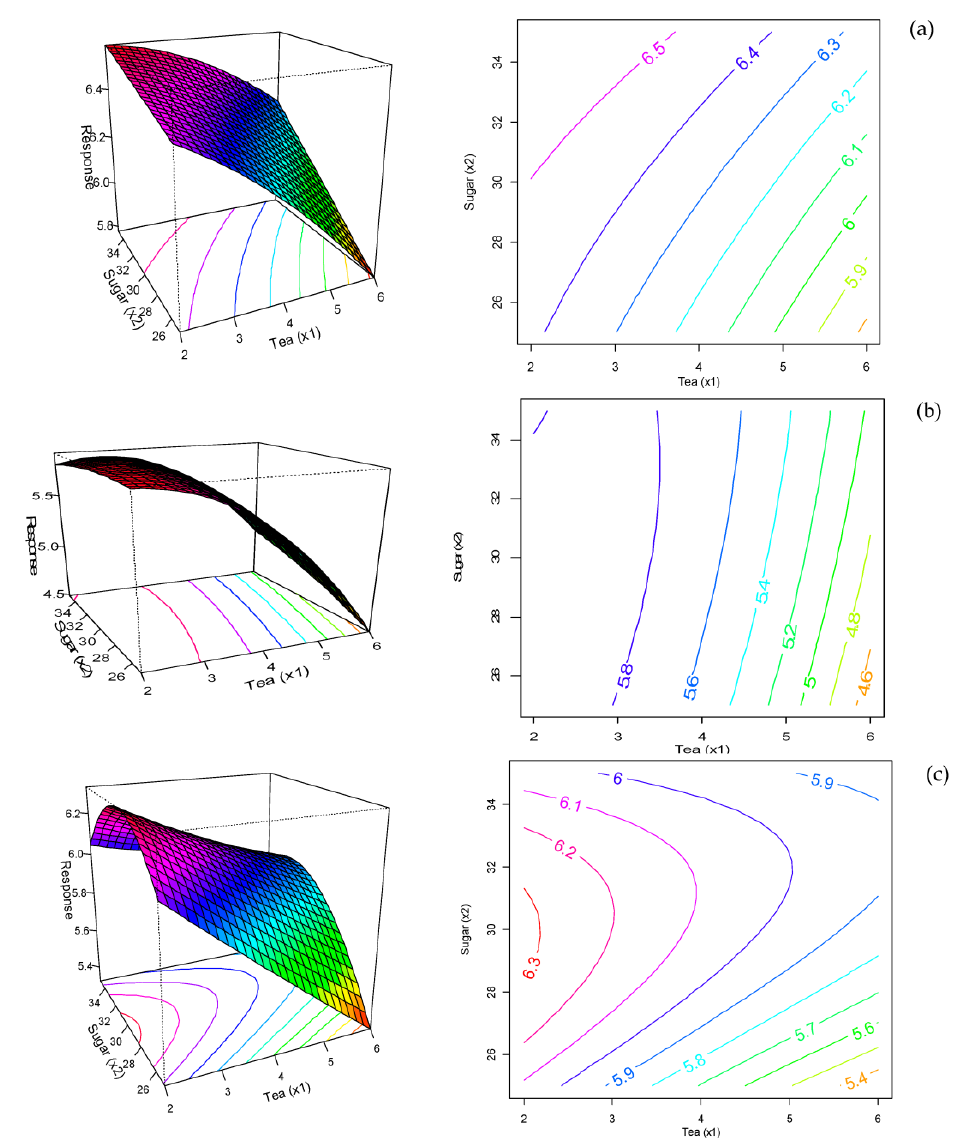
Figure 4. Response surfaces and contour plots of the effect of MGTP and sugar content incorporated ( a ) texture, ( b ) bitterness, and ( c ) sweetness acceptability of